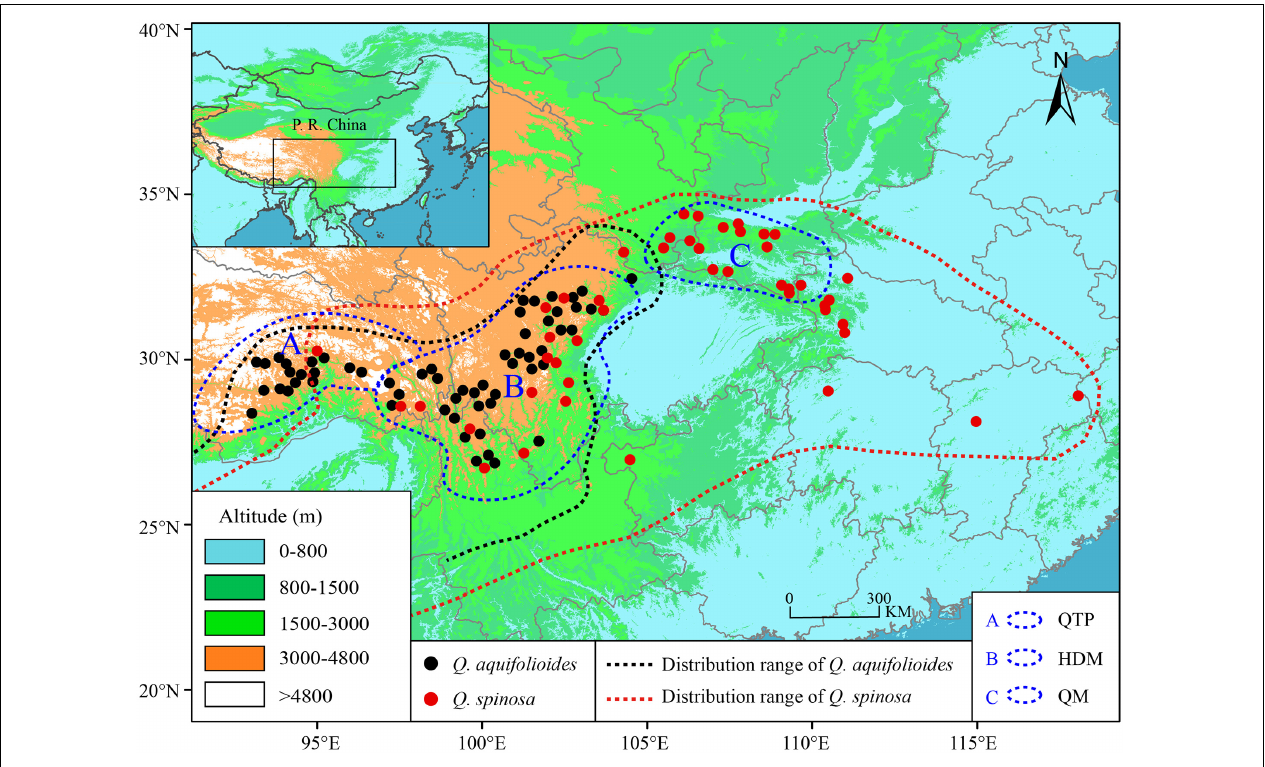
FIGURE 1 | Geographic distribution and sampling sites of Q. aquifolioides and Q. spinosa . Black and red dashed lines indicate the geographic distribution of Q. aquifolioides and Q. spinosa , respectively. Three blue dashed lines represent defined research areas. The black rectangle on left top map represents the whole research area. QTP: Qinghai–Tibet Plateau, HDM: Hengduan Mountains, QM: Qinling